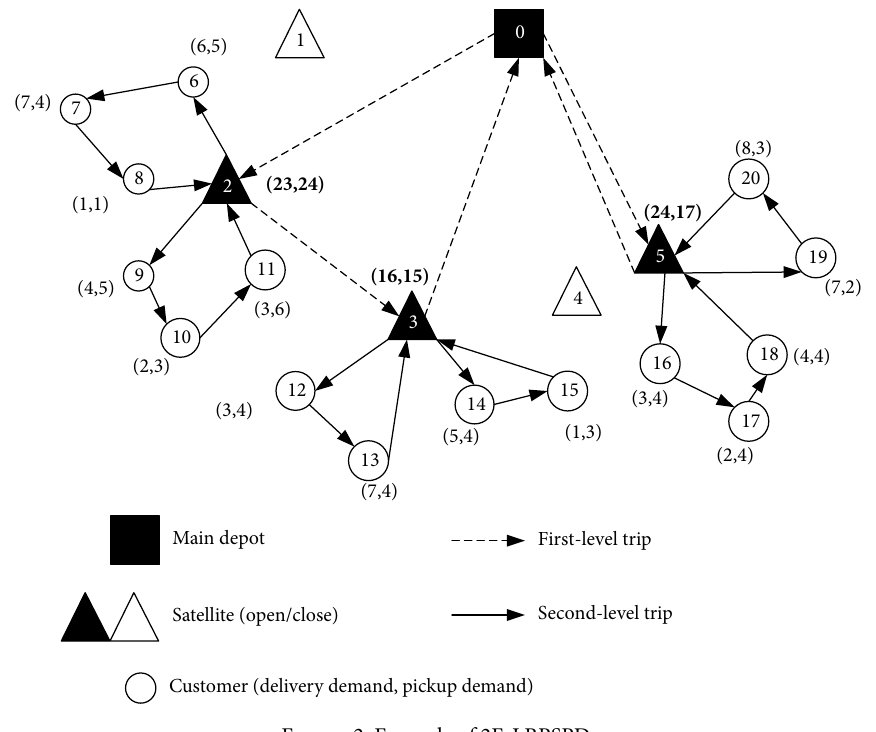
Figure 2: Example of